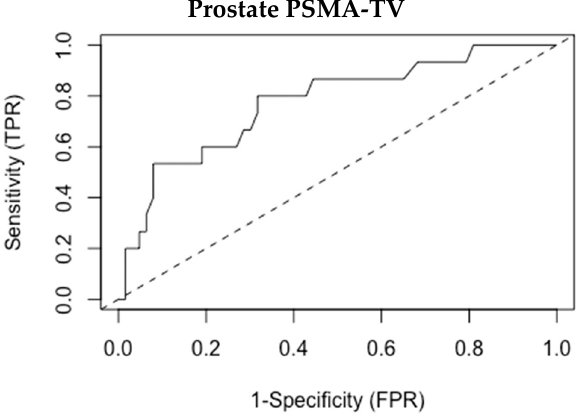
Figure 2. ROC analysis for prostate PSMA-TV. Table 3. Prostate PSMA ‐ TV values and presence of metastases.